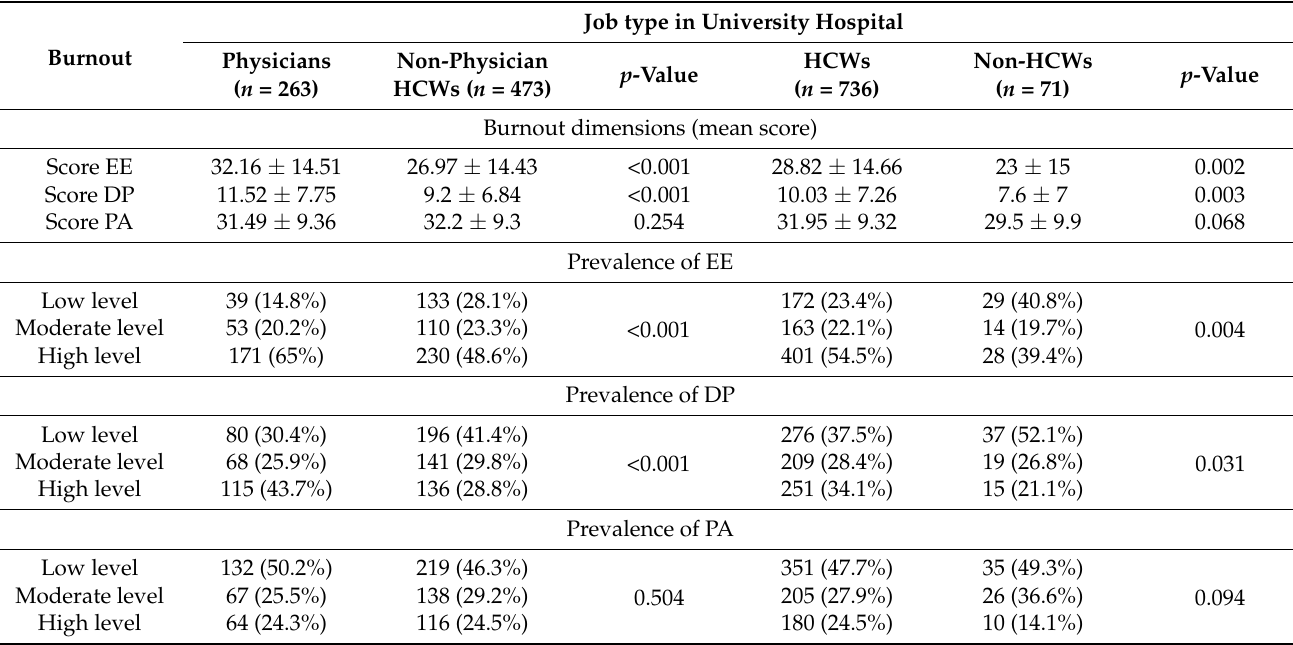
Table 4. Burnout dimensions with respect to job type in hospital.